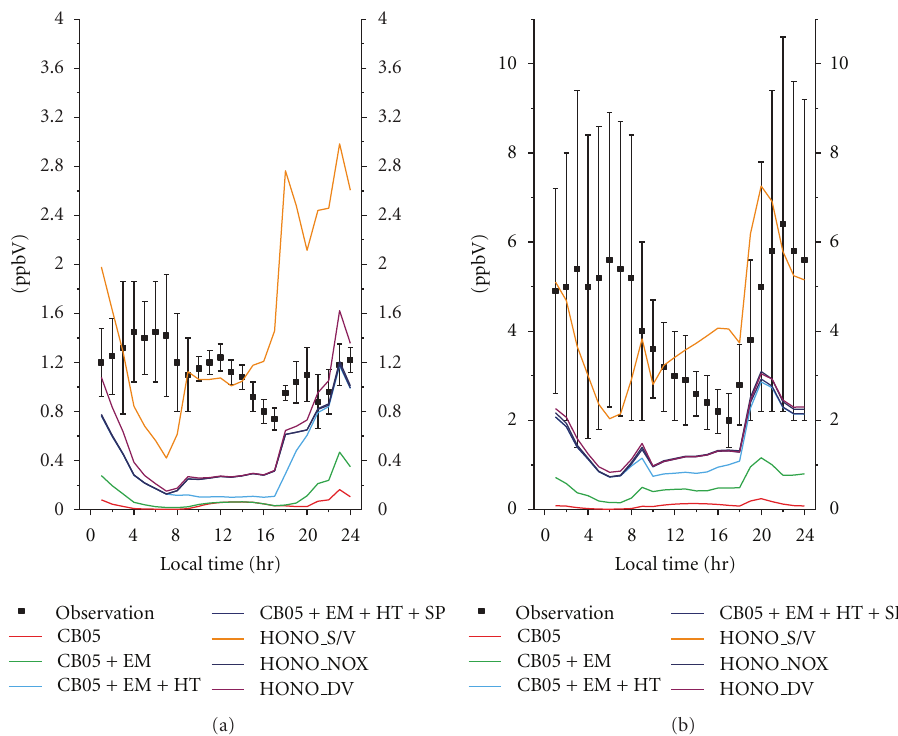
Figure 7: Diurnal pattern of simulated HONO at (a) Xinken and (b) Guangzhou with di ff erence simulation cases.